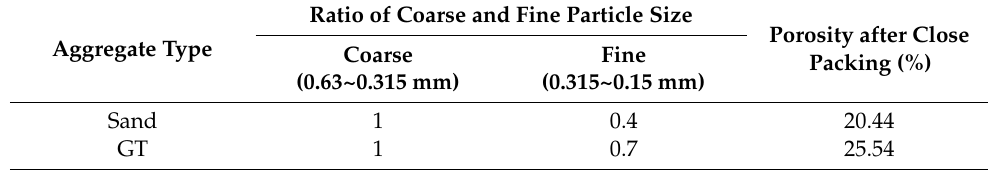
Table 6. Optimal gradation of sand and GT. Preliminary determination of different grades of sand and GT The maximal bulk density of sand/GT per unit volume refers to the sum of the initial dosages of aggregates in different particle size ranges. Based on Equation (1), the